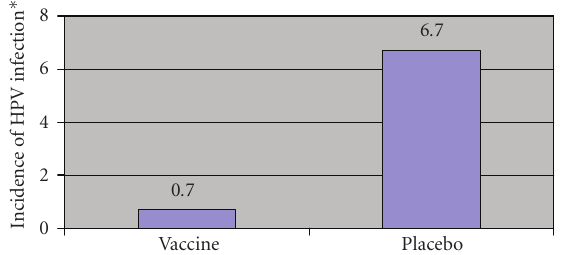
Figure 3: Incidence of infection or disease associated with HPV 6, 11, 16, or 18 after vaccination with a quadrivalent vaccine versus placebo ( ∗ reported as incidence per 100 women-year at risk)